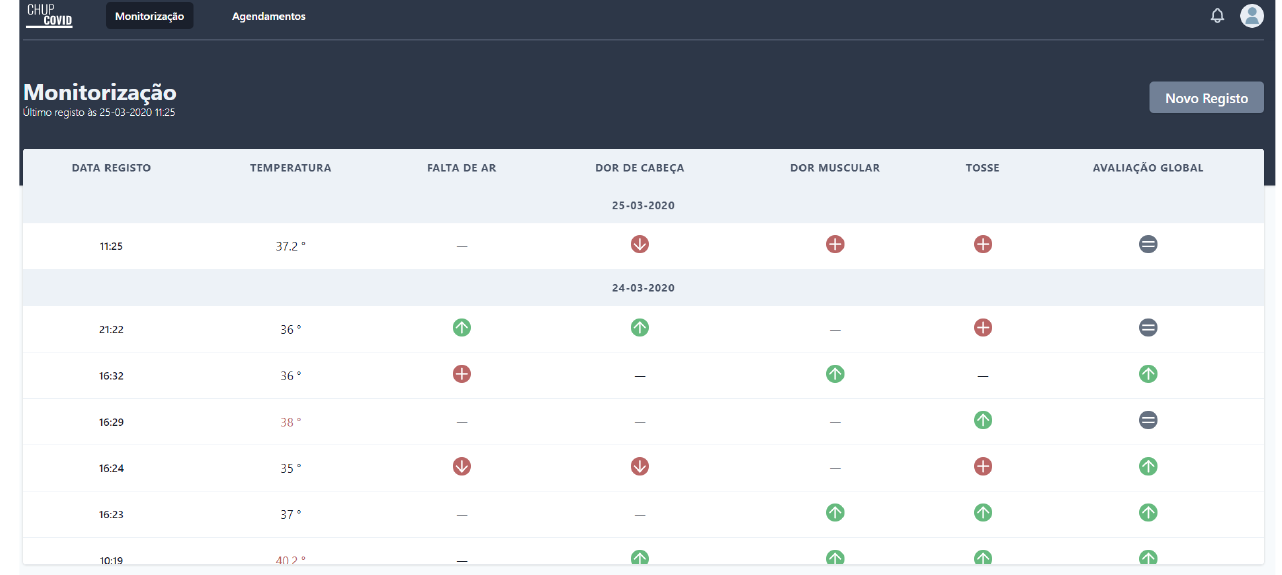
Figure 4. CHUP Monit home page (history data of previous interactions).